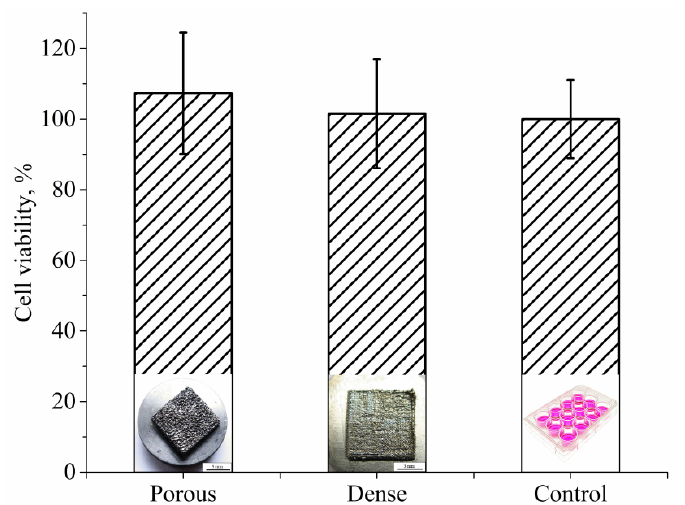
Figure 18. MG63 cell viability test for porous and dense Ti-Nb samples after 7 days of incubation. The LPBF samples were tested for cytotoxicity using fluorescence microscopy.